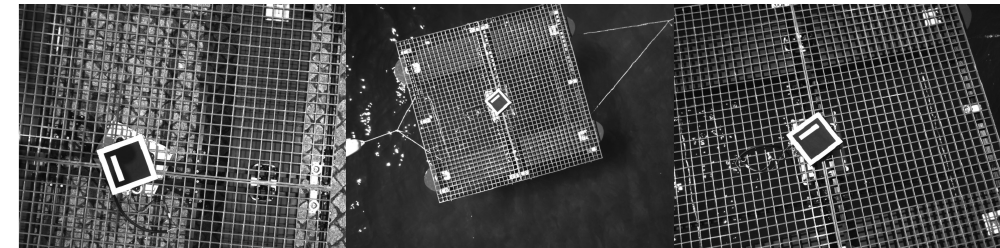
Figure 7. Samples from the visual dataset.